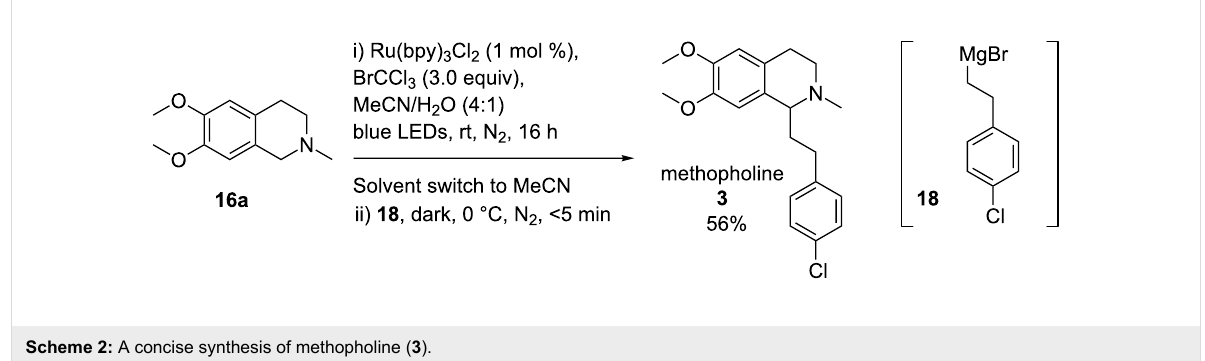
Table 3: Direct one-pot organometallic additions to iminium salts generated via visible-light photoredox catalysis.